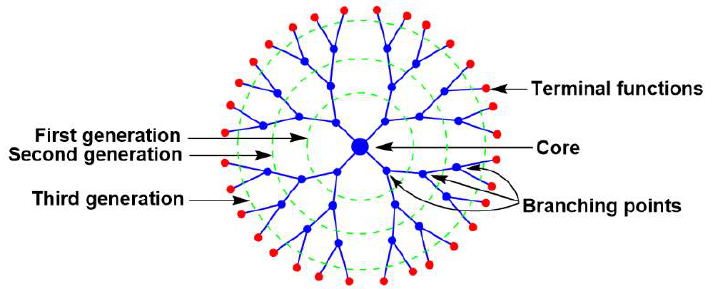
Figure 1. Schematized third-generation dendrimer, showing its main structural features.